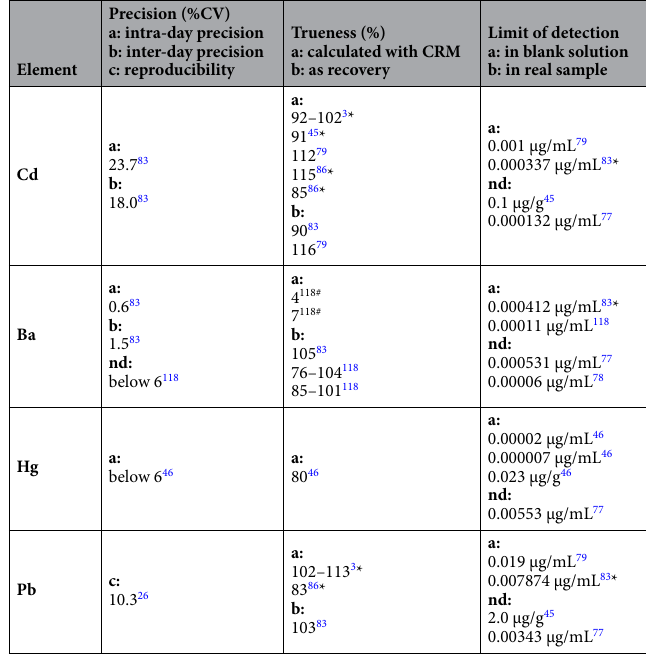
Table 3. Values of precision, trueness and detection limit for different elements determined by using ICP- OES. nd method of parameter determination was not defined; # Trueness expressed as a Bias; *Calculated based on the literature